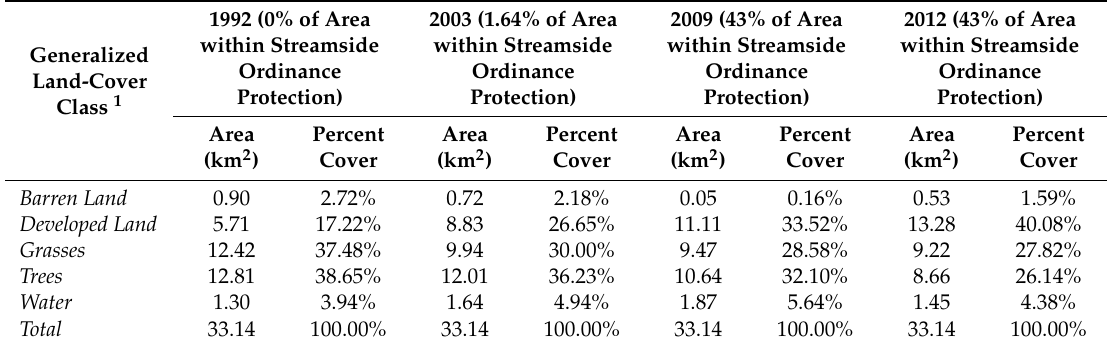
Table 3. Land-cover within the total selected study area for pre- and post-streamside ordinance categories and selected years that correspond to SPOT image